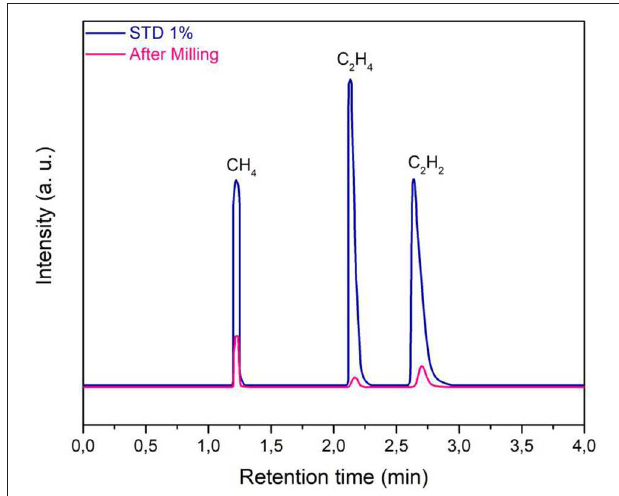
FIGURE 2 | Gas-chromatographic analysis, by FID, of the gas phase sampled from the mechanochemical reactor. Experimental data, reported as pink line, are compared with the relevant standard mixture data (STD), relative to 1% concentration value.